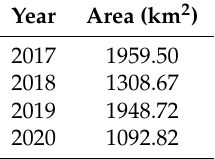
Table 4. Area (km 2 ) of Poyang lake from 2017 to